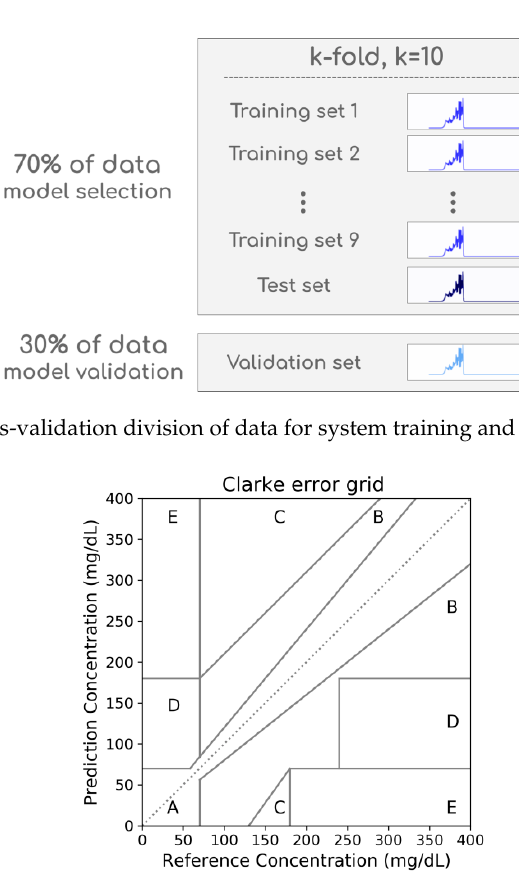
Figure 2. Zones on the Clarke error grid analysis.